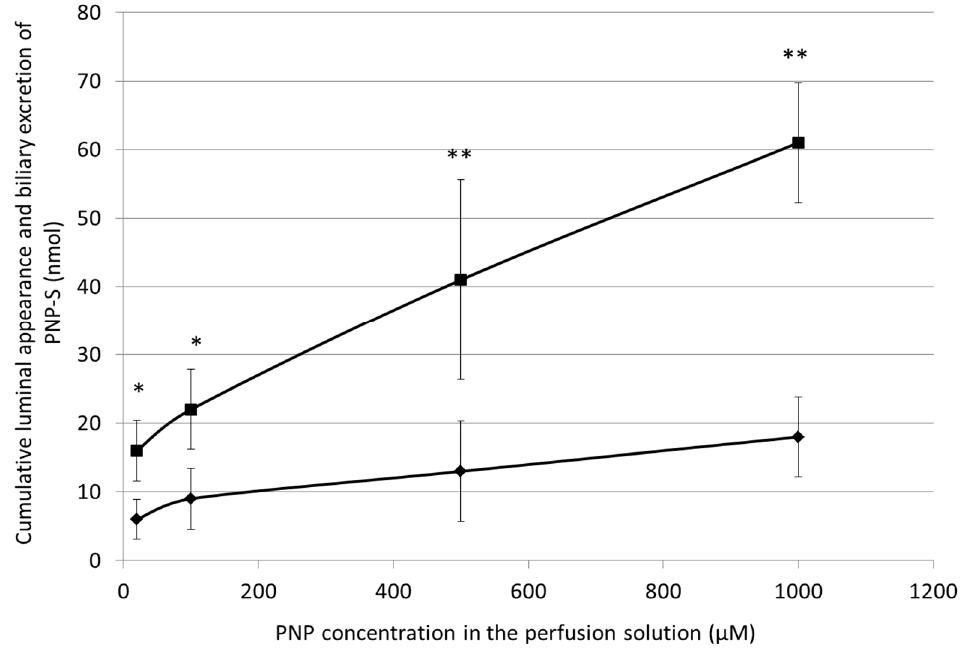
Figure 6. Cumulative luminal appearance ( ♦ ) and biliary excretion ( ■ ) of PNP-S measured in 90 min perfusion of 20 µM, 100 µM, 500 µM, and 1000 µM PNP in the small intestine (proximal jejunum). Values represent the mean ± S.D. of eight rats. Significant difference between the values of luminal appearance and biliary excretion of PNP-G: * p < 0.05; ** p < 0.01.